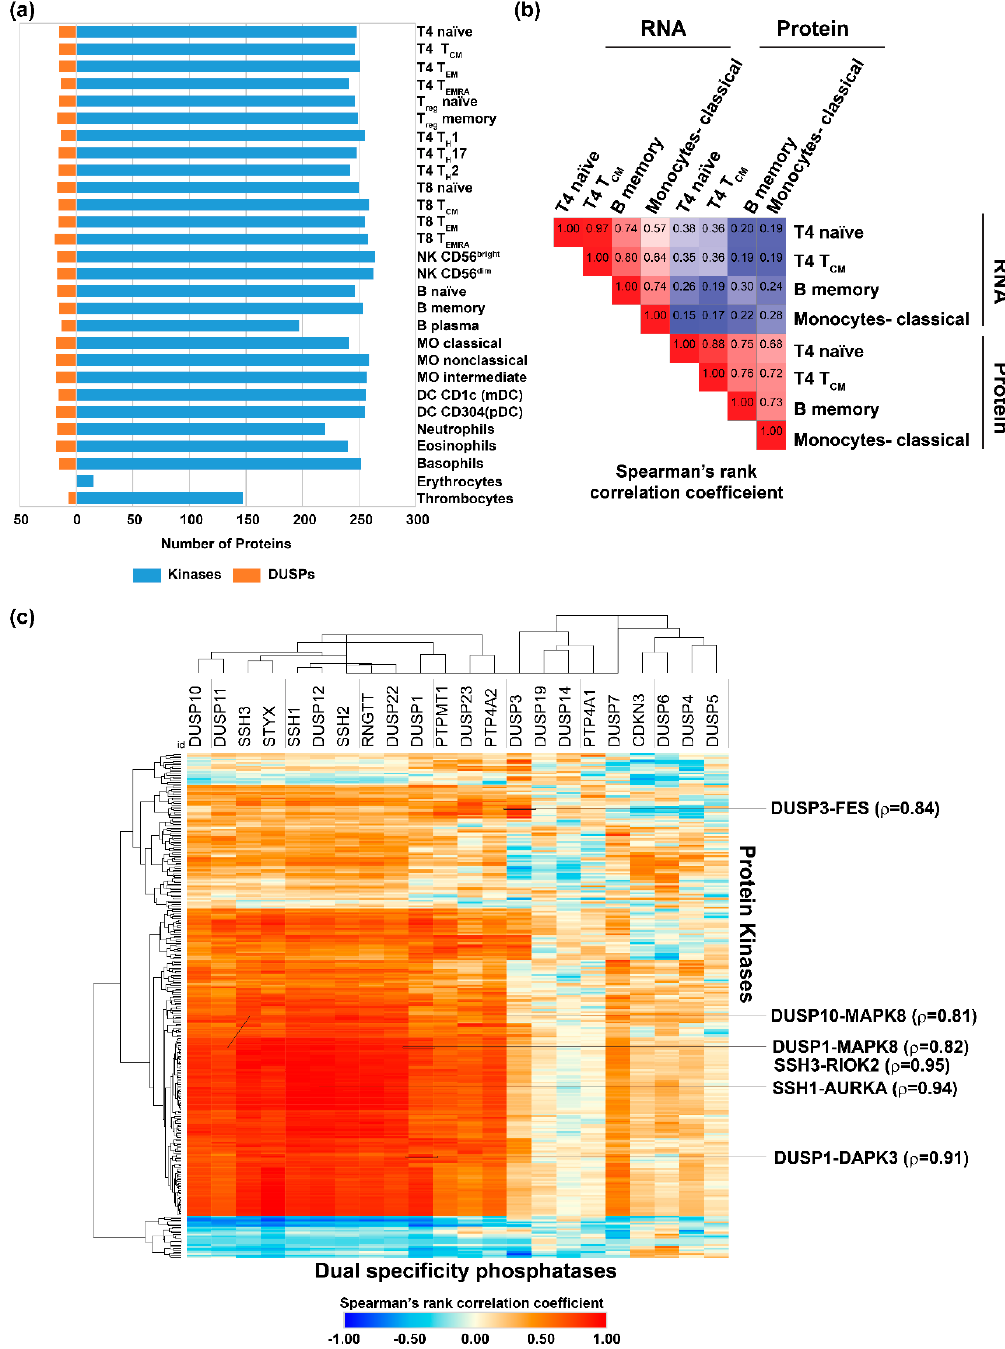
Figure 2. ( a ) Protein kinases and dual specificity phosphatase expression in hematopoietic cells. Hematopoietic cell expression data for protein kinase and dual specificity phosphatases (DUSPs) were obtained from Rieckmann et al., Nat Immunol (2017) [29]. All hematopoietic cells except erythrocytes and thrombocytes expressed similar number of kinases and DUSPs. ( b ) Correlation of transcriptomic and proteomic data of cells. Transcriptomic and proteomic data for T4 naïve, T4 TCM, B memory and classical monocytes from Rieckmann et al., Nat Immunol (2017) [29] showed poor correlation. ( c ) Correlation of protein kinase and DUSP expression patterns in hematopoietic cells. The correlation was carried out using Spearman’s rank correlation to identify kinase-DUSP pairs that may have reciprocal activities. The kinase-DUSP pairs with high correlation coefficients are shown on the right-hand side.